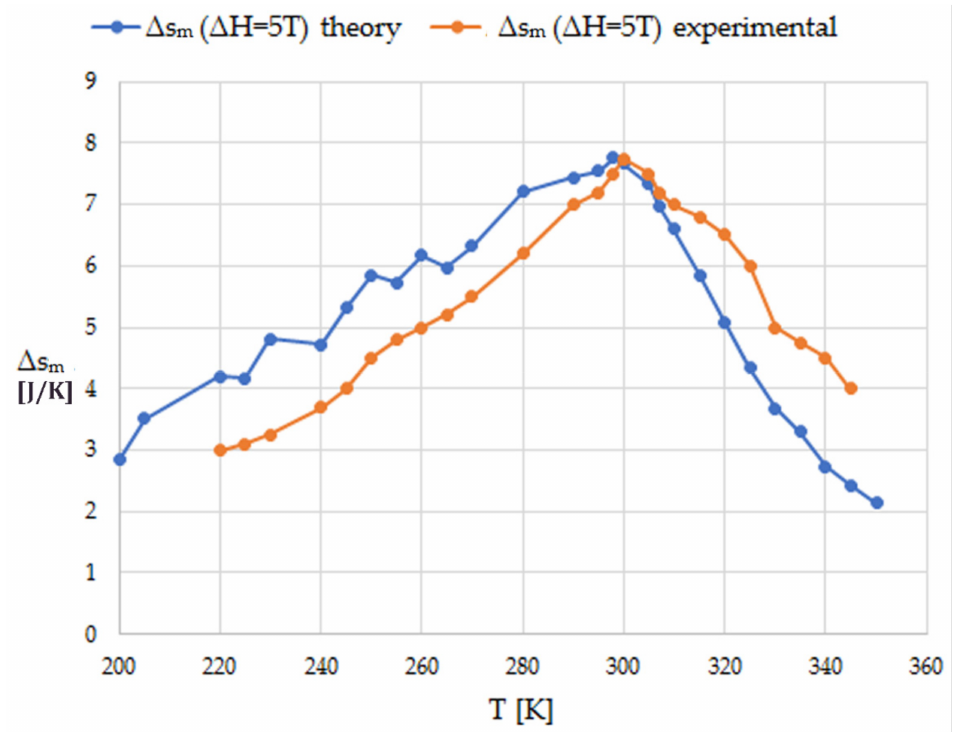
Figure 10. Comparison between theoretical and experimental values of the isothermal variation of magnetic entropy as the temperature varies considering a magnetic field variation of